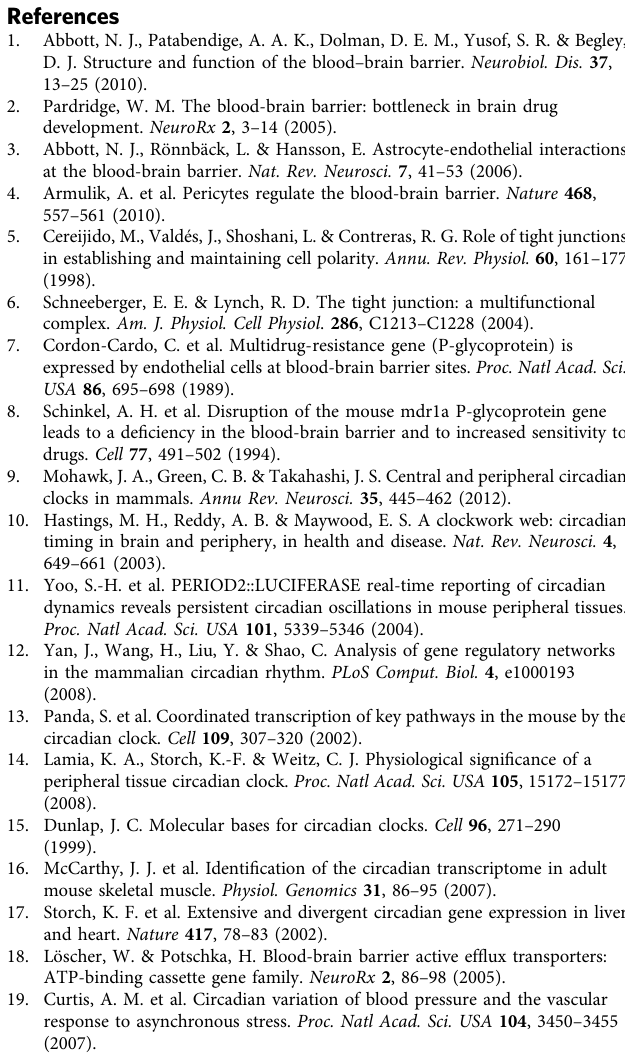
mentary Table 4. Assays were run on ViiA7 Real-Time PCR system (Applied Biosystems). Relative gene expression was calculated using the ΔΔ Ct method normalizing to